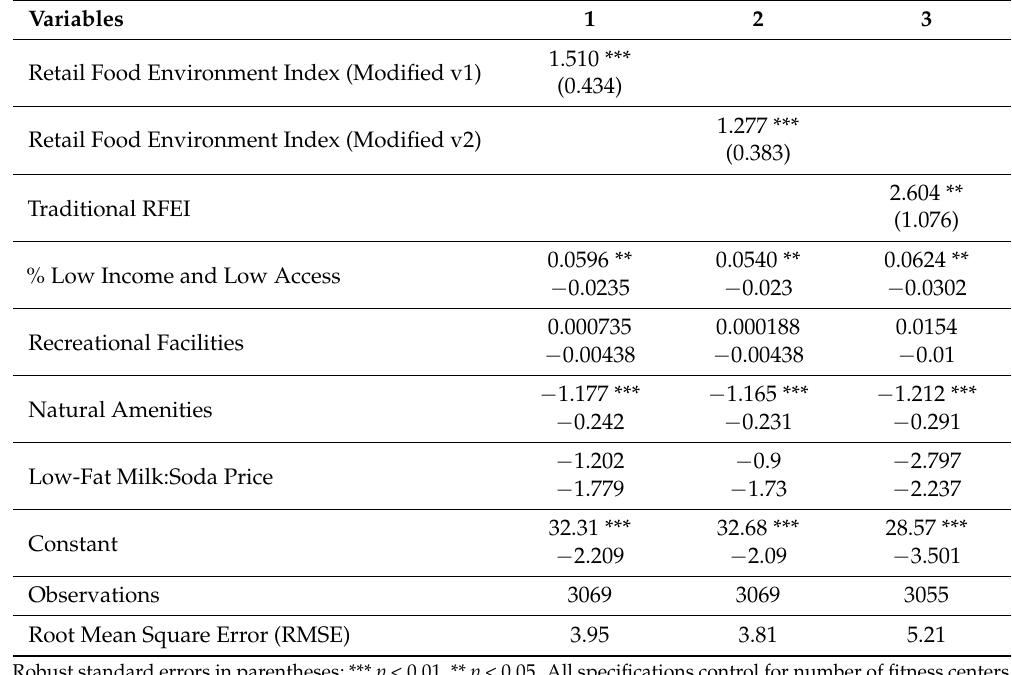
Table 8. Coefficient estimates of food swamps on obesity rates using instrumental variable, N =